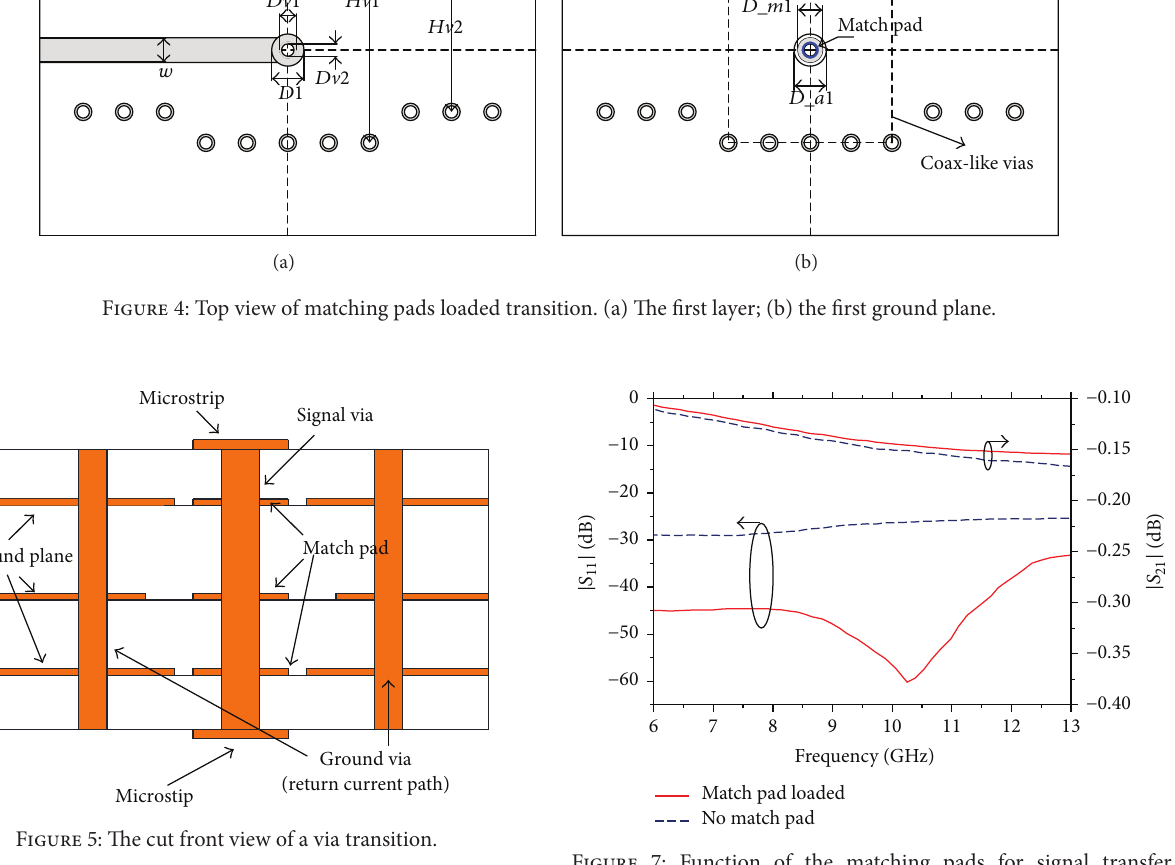
Figure 7: Function of the matching pads for signal transfer